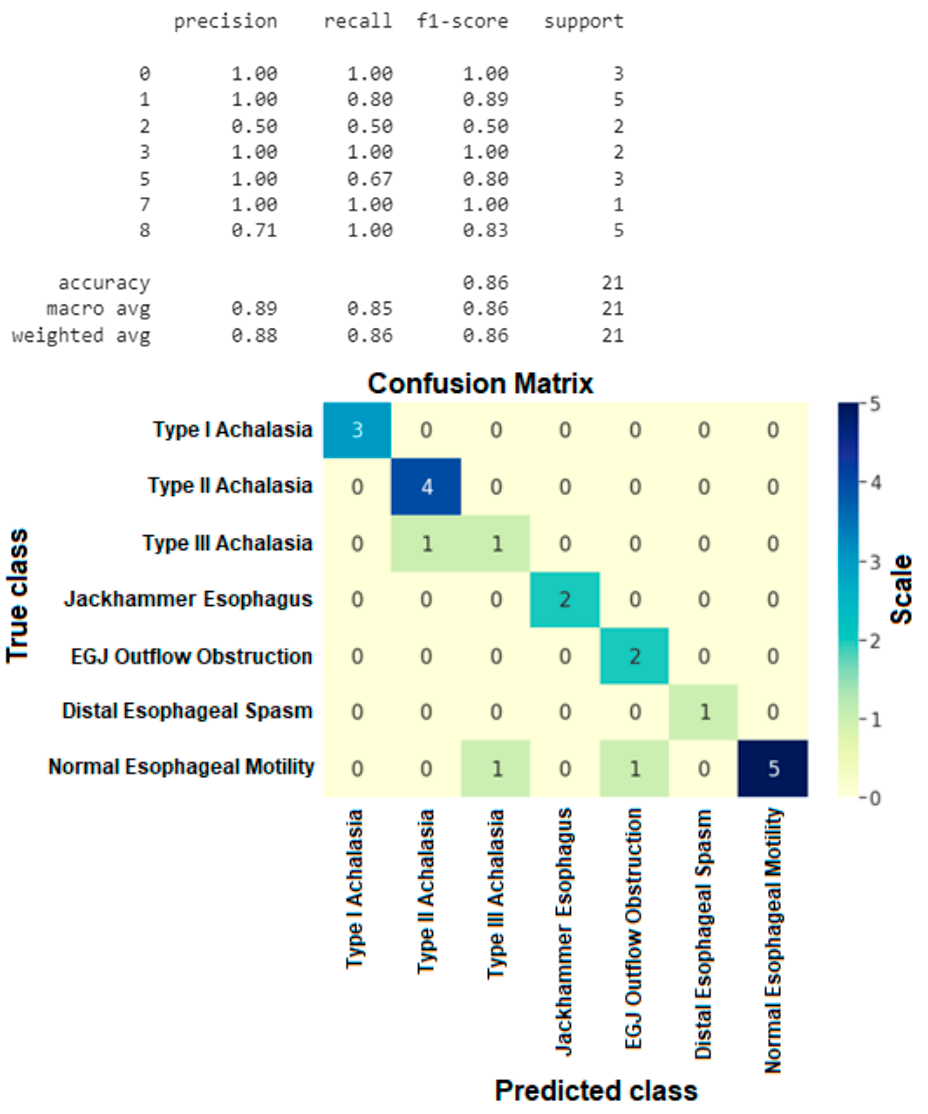
Figure 9. Esophageal motility disorders confusion matrix without ineffective esophageal motility and fragmented peristalsis disorder classes.